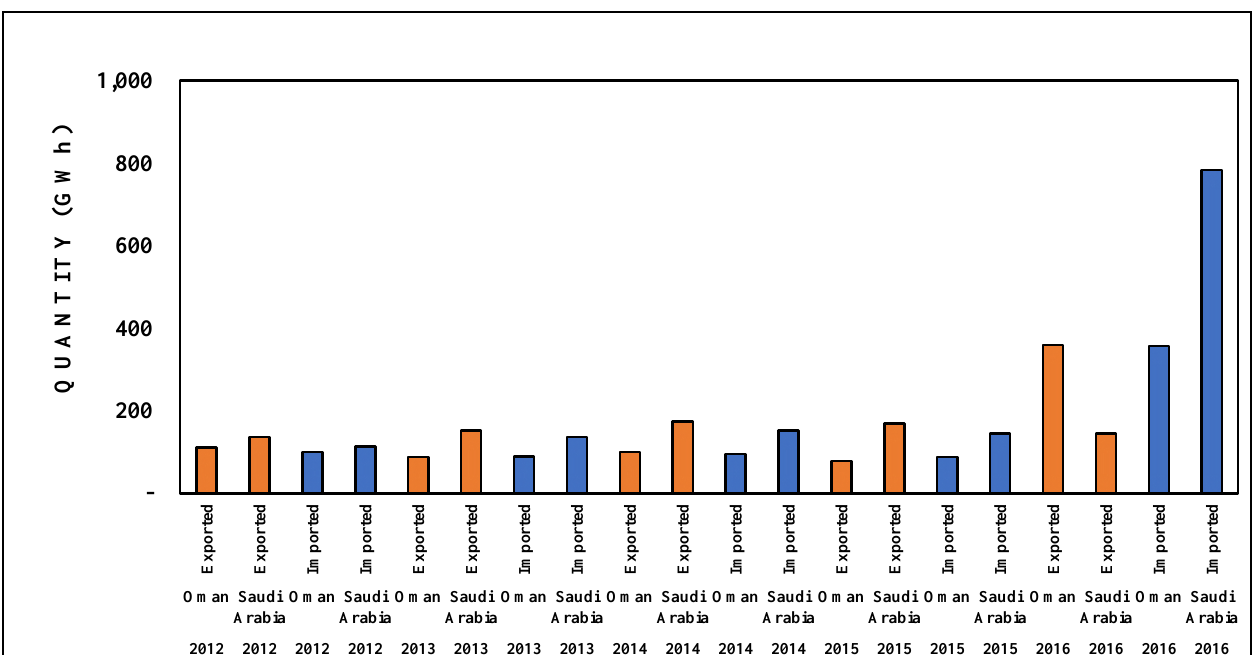
Figure 15. Gross generated electricity (GWh) by authority [81].